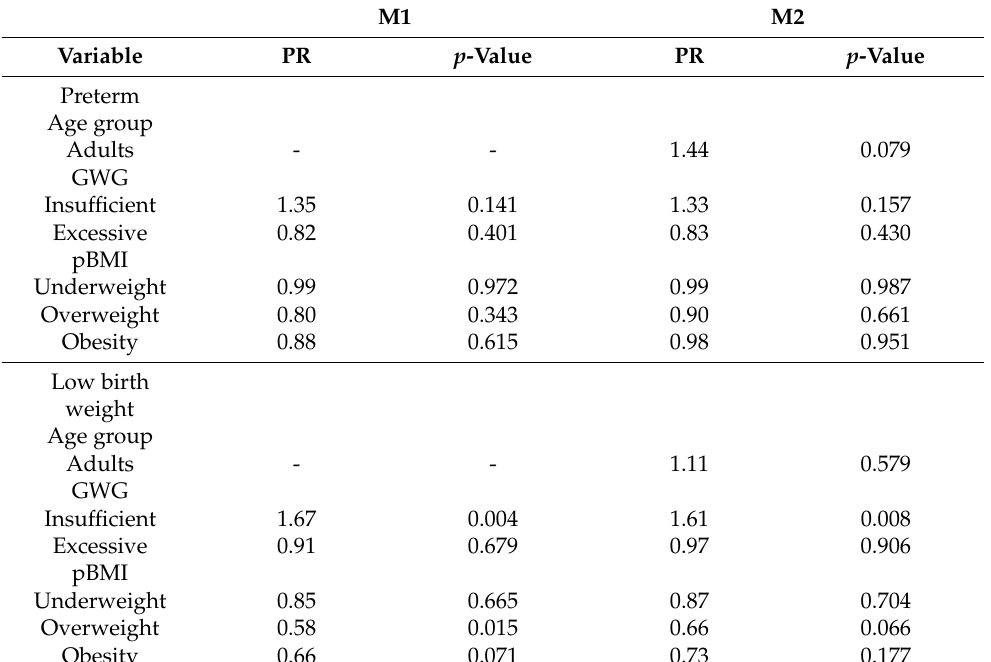
Table 4. Poisson regression models for the association of GWG and pBMI with preterm birth, small for gestational age and low birth